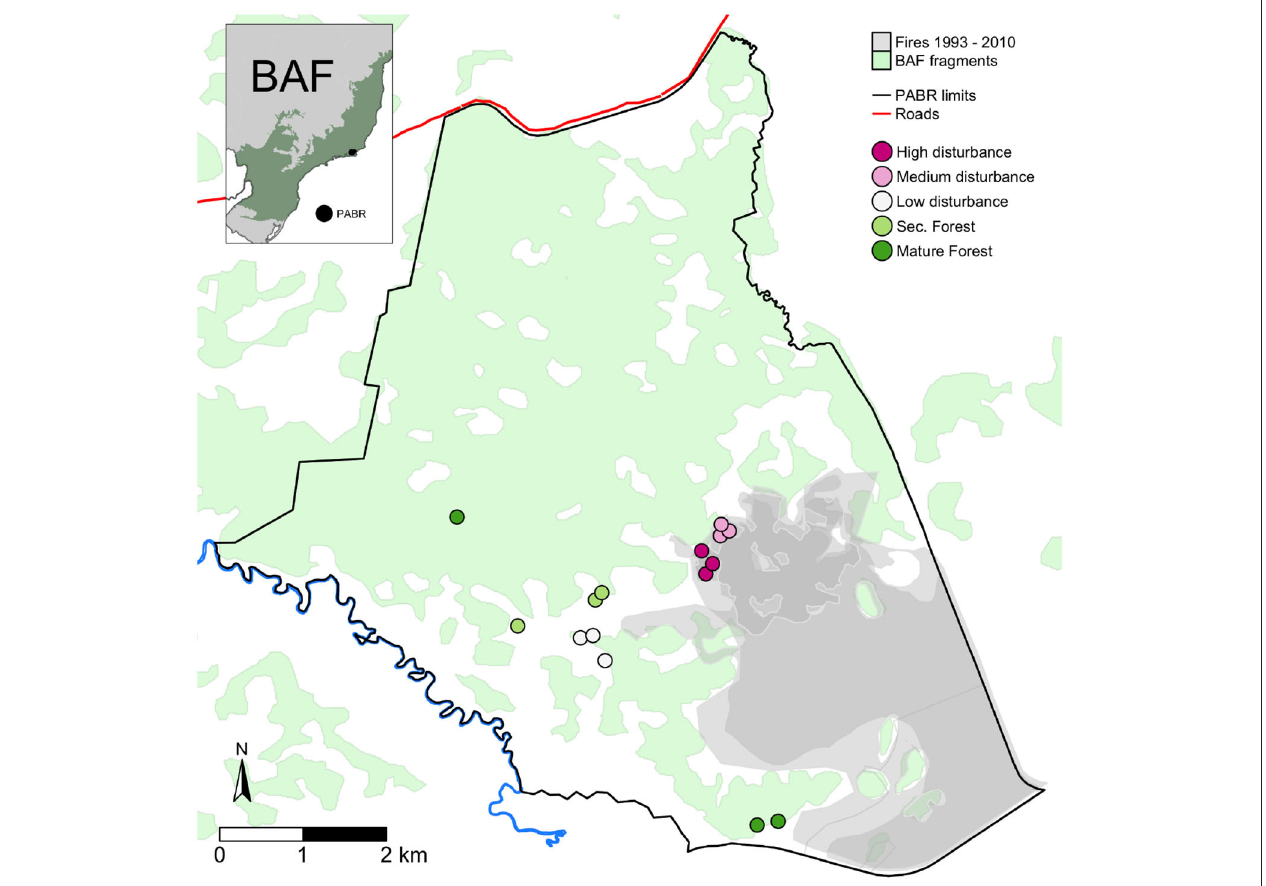
FIGURE 1 | The study area at the Poço das Antas Biological Reserve (PABR, black line), a Biological Reserve located in the eastern portion of the Brazilian Atlantic Forest (BAF). The green area in the inset map corresponds to the official limits of the BAF ( IBGE, 2019), and the remaining BAF forest fragments (SOS Mata Atlântica, 2010) are depicted in light green in the main map. We established the fire history since 1993–2010 (overlapping gray areas), from maps made by the PABR staff. An additional fire in 1990 has no official map but it affected the High, Medium, and Low disturbance areas (last burned in 1990). The burned areas are mostly abandoned pastures and peatlands, and we positioned our sampling plots along the pasture-to-forest transition, where vegetation is regenerating. Each point in the map corresponds to a 60 × 30 m plot, subdivided in 10 × 10 m subplots. The fire history is detailed in Table 1 .